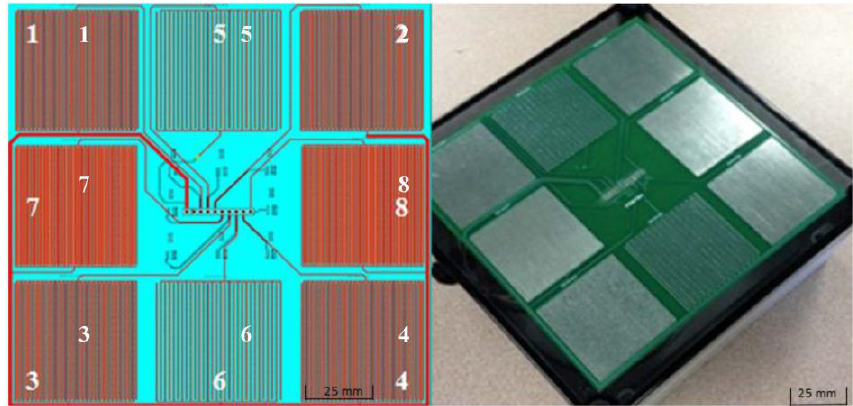
Figure 1. Design schematic with sensor ID numbers ( left ) and photo ( right ) of spray deposition sensor array used during testing. Table 1. Sensor array trace gap spacing between traces and widths of traces.